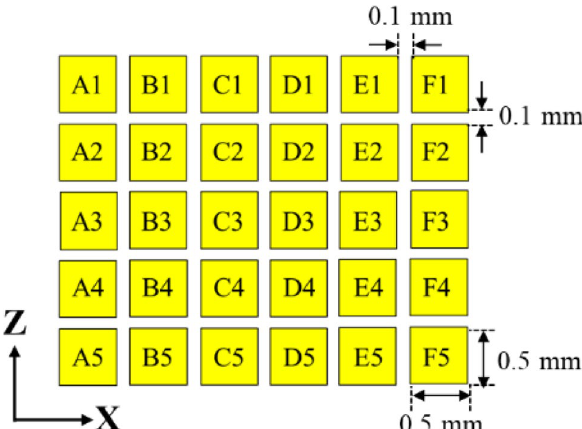
Figure 1. The detailed arrangement of the mini-LED matrix.